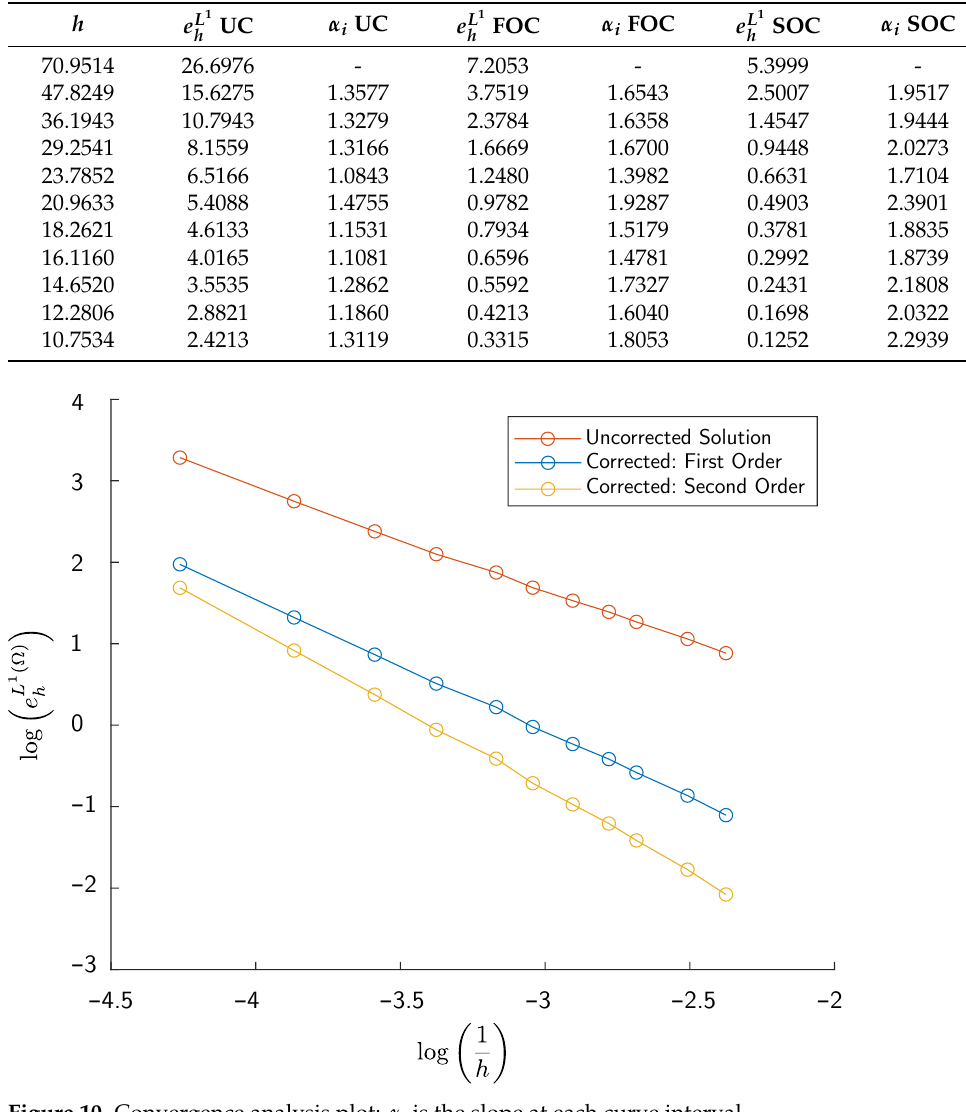
Figure 10. Convergence analysis plot: α i is the slope at each curve